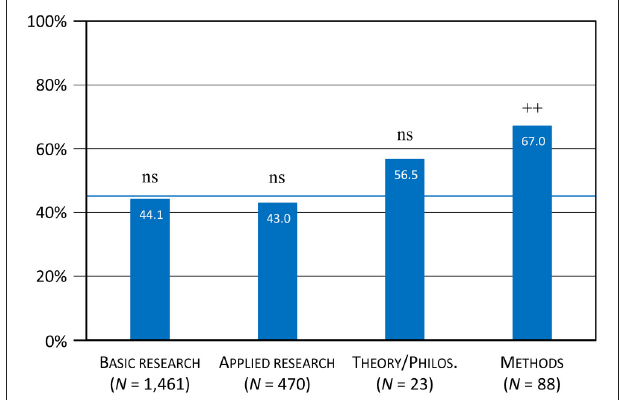
FIGURE 4 | Proportion of specialty categories with theory-related terms ( Table 5B , all six terms). The blue line represents the average proportion of 45.0% based on the total of 2,042